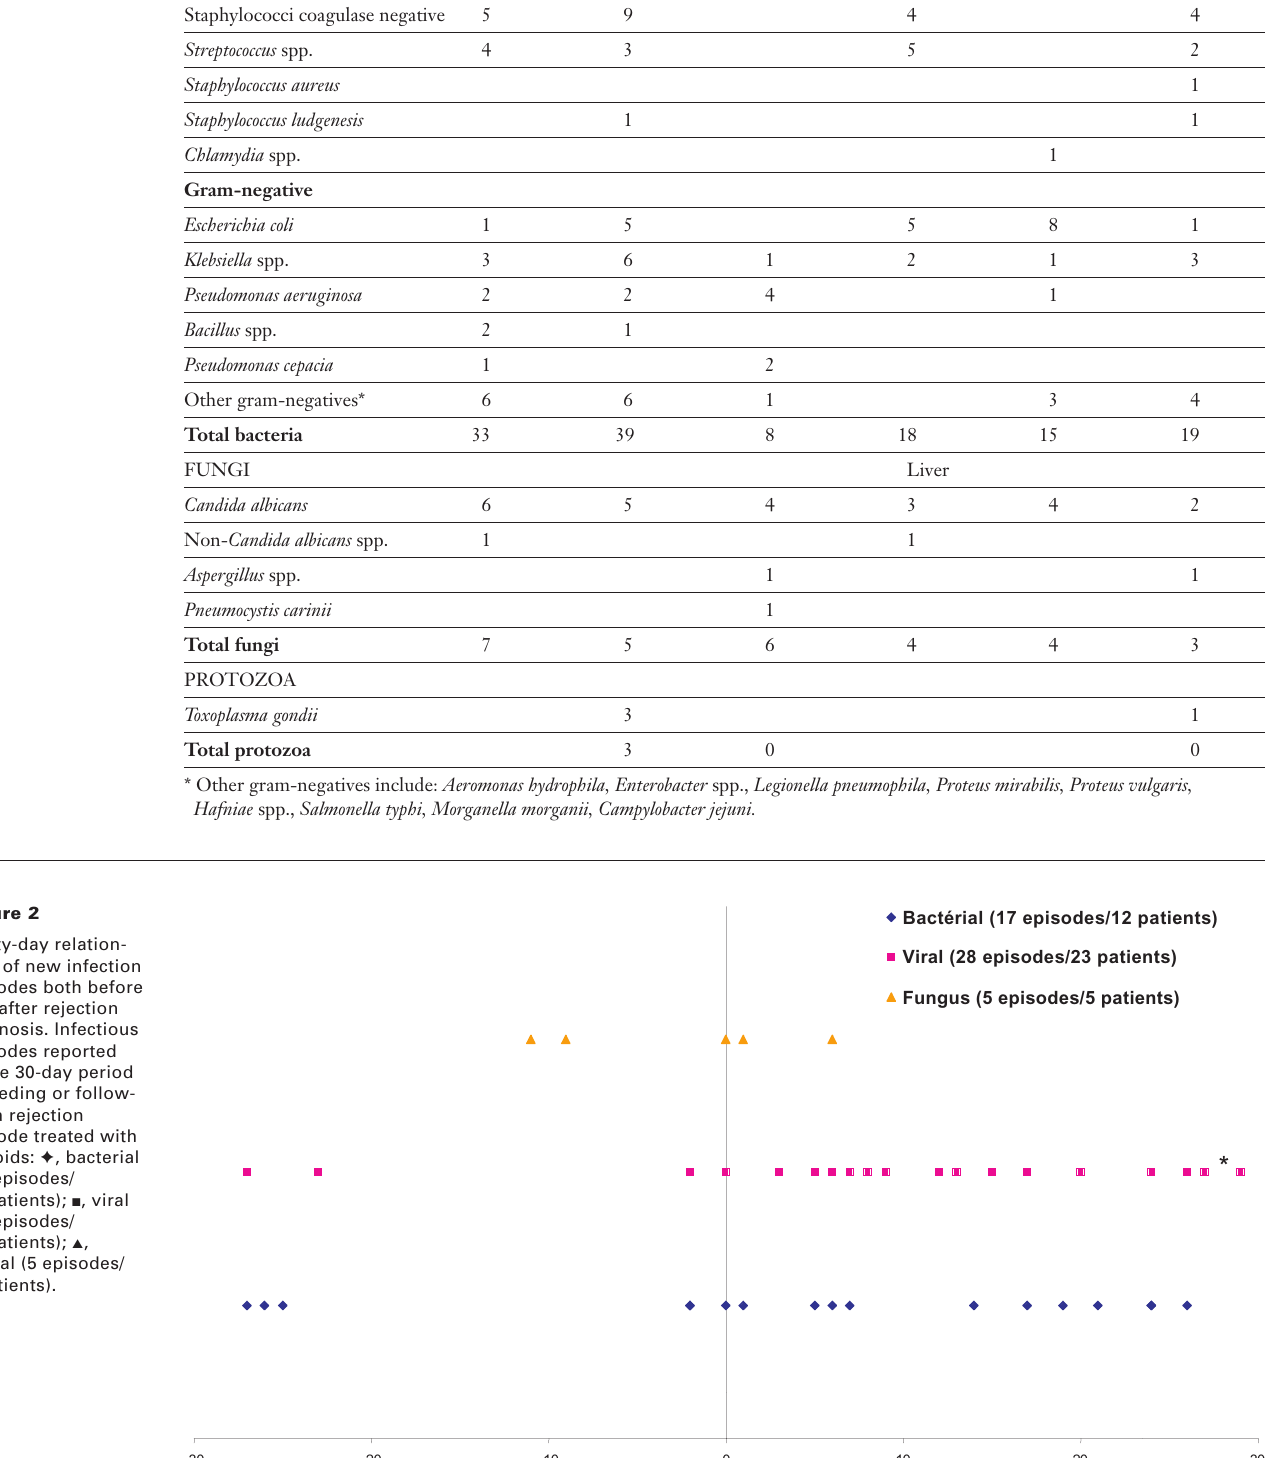
Table 2 Distribution of bacterial, fungal and protozoan pathogens and infection sites among liver trans- plant